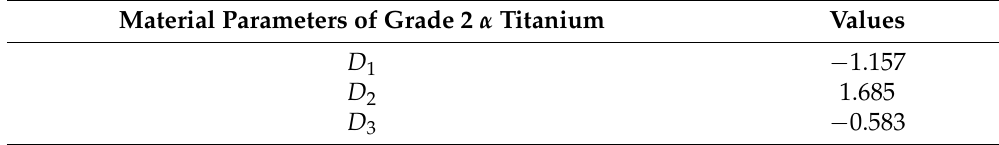
Figure 14. Fracture strain as function of stress triaxiality. Table 7. Johnson–Cook failure parameters for Grade 2 α titanium.